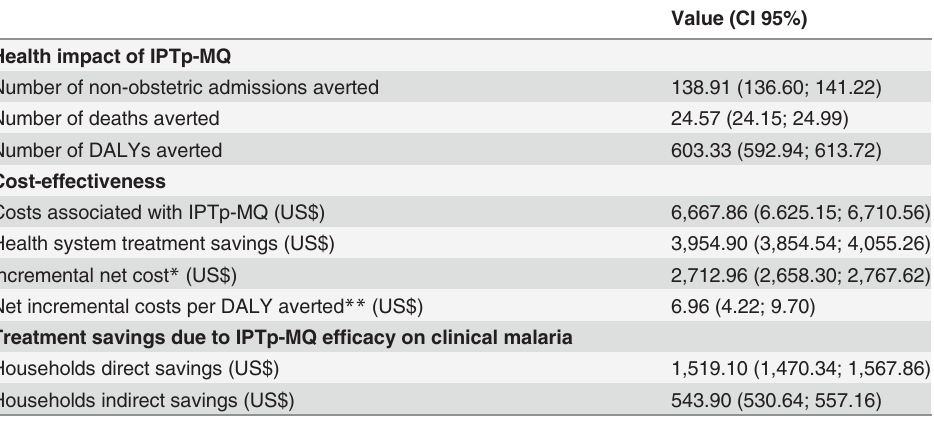
Table 4. HIV-positive trial: Results of the cost-effectiveness analysis (per 1000 pregnant HIV-positive